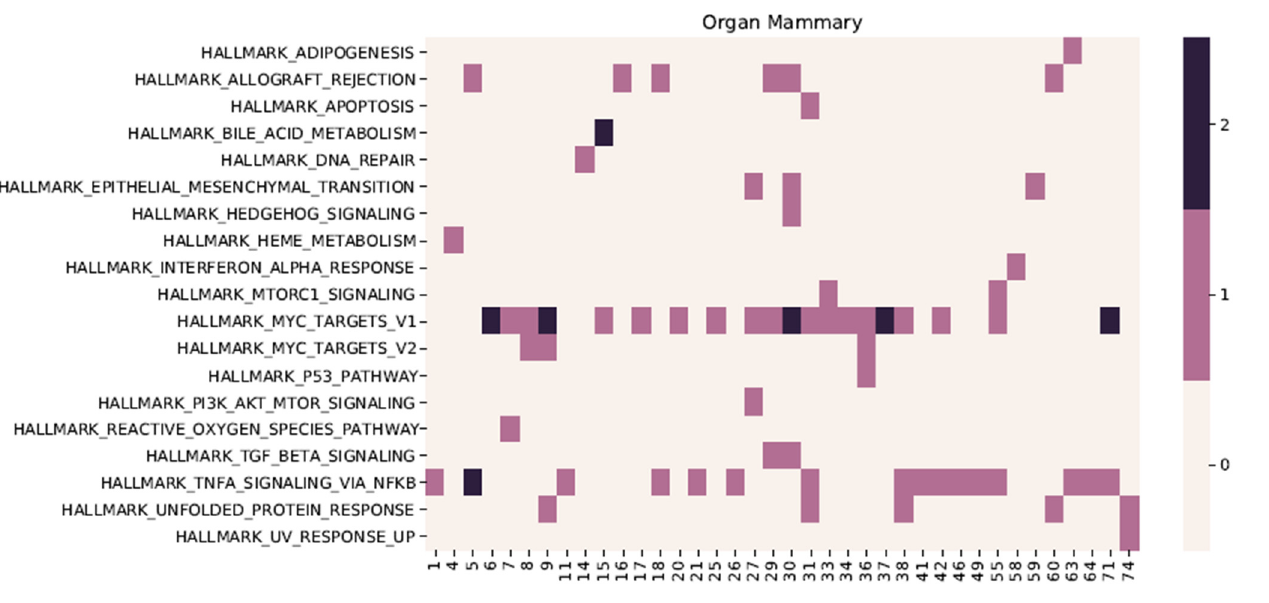
Figure 5. Model trained on Muscle dataset from Smart-seq2 with orthogonality constraint used to compute the saliency maps for each cell type in the Mammary dataset. Heatmap shows frequency that each pathway was significant. The saliency map from each bottleneck layer was thereby used as an input to the GSEA analysis to compute the number of times a given pathway was significant. The x -axis represents the (nth-bottleneck layer), and the color of the heatmap displays how many times the given Hallmark pathway was found significant, considering that the mammary dataset has 4 cell types. Only hidden units with at least one significant pathway are displayed.